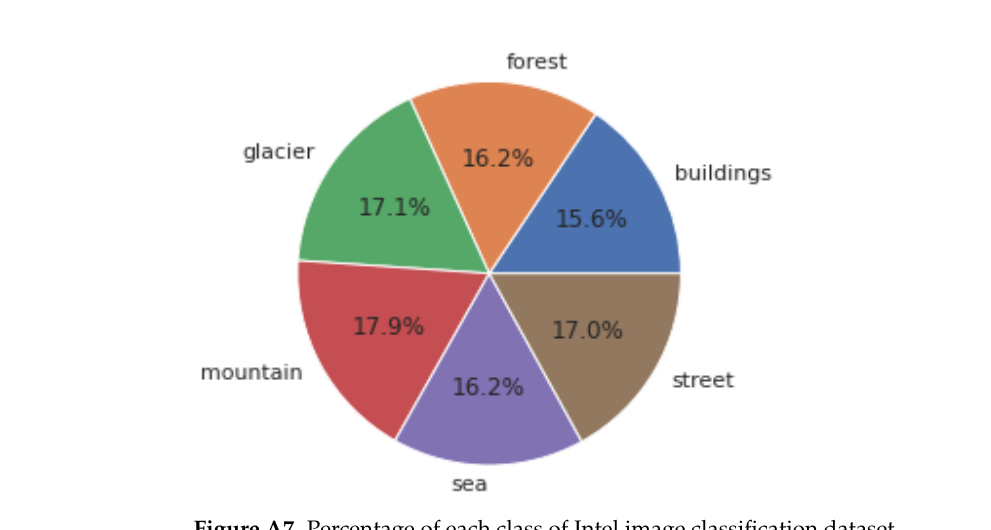
Figure A7. Percentage of each class of Intel image classification dataset.